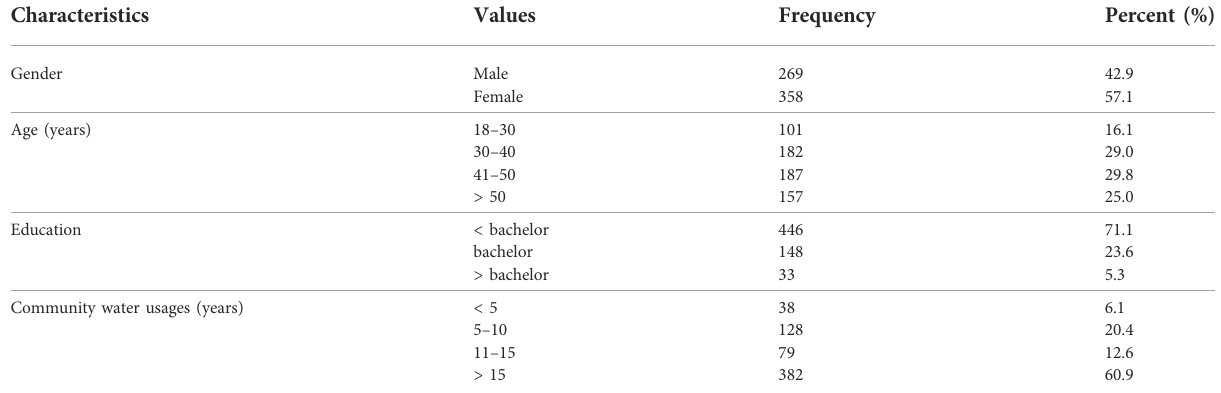
TABLE 3 Demographic data of main testing respondents, Total (N =